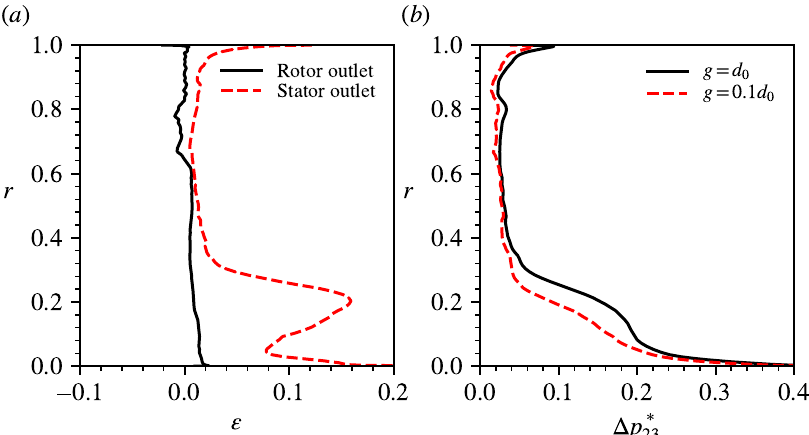
Figure 15. Spanwise distributions of ( a ) the incremental ratio of the total pressure rise on the rotor and the stator outlets when the gap reduced from d 0 to 0.1 d 0 and ( b ) the total pressure loss coefficient of the stator at the two